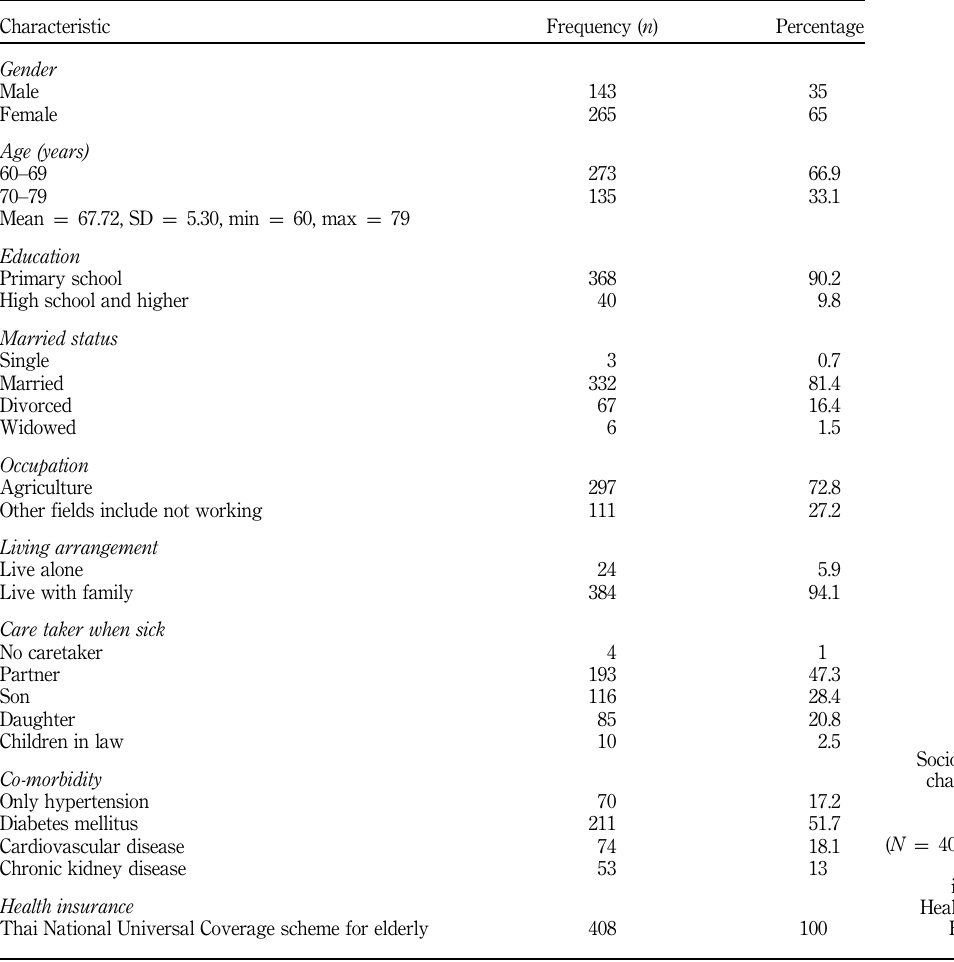
Table I. Sociodemographic characteristics of elderly